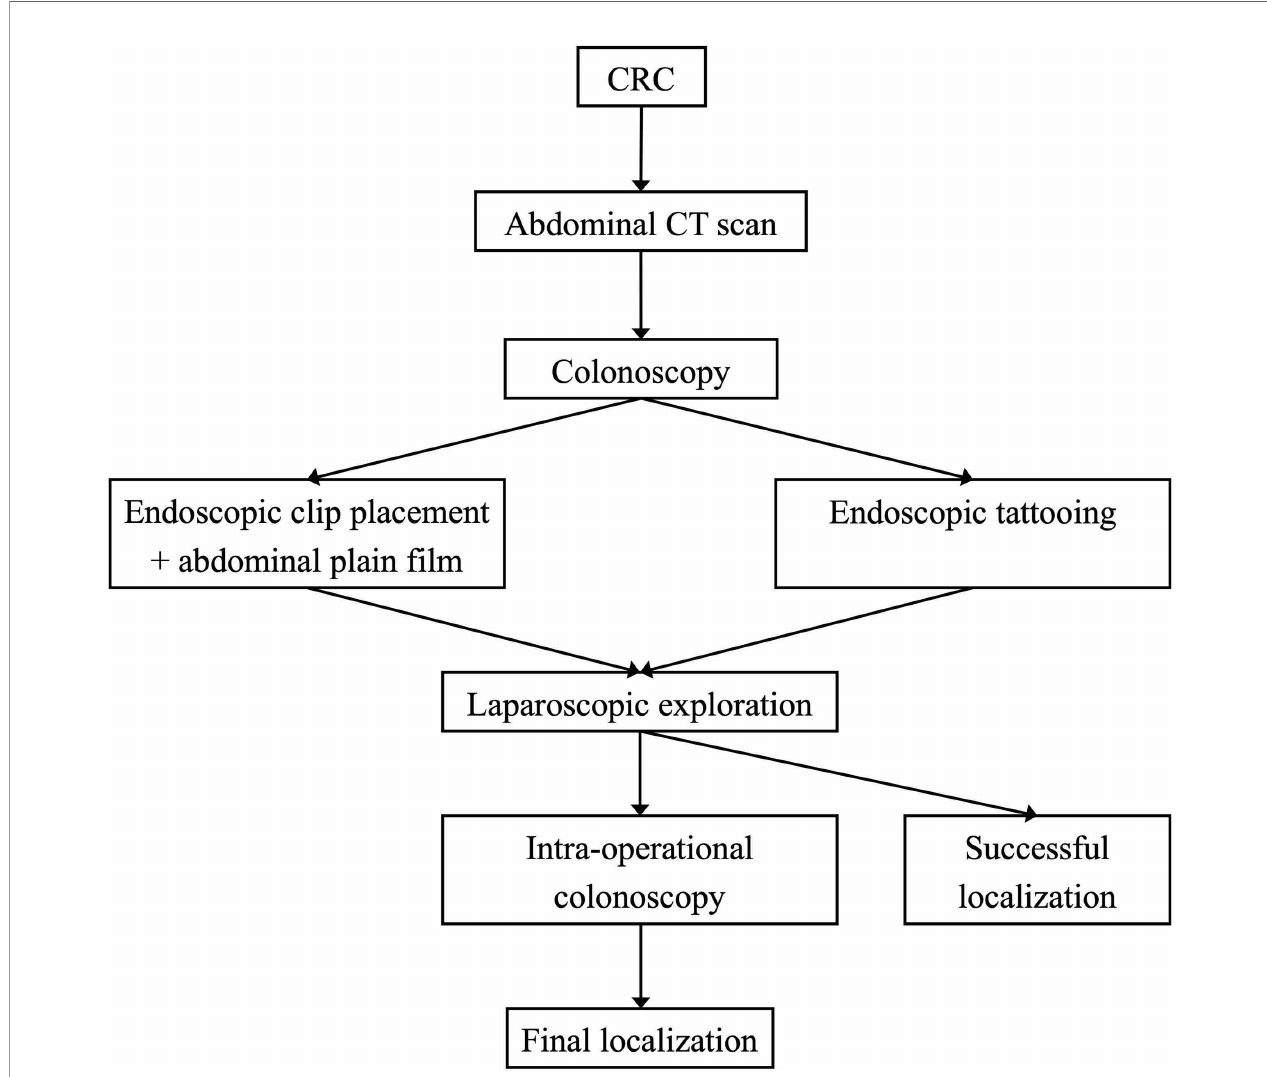
FIGURE 2 | Two endoscopic localization strategies for colonic tumors in laparoscopic